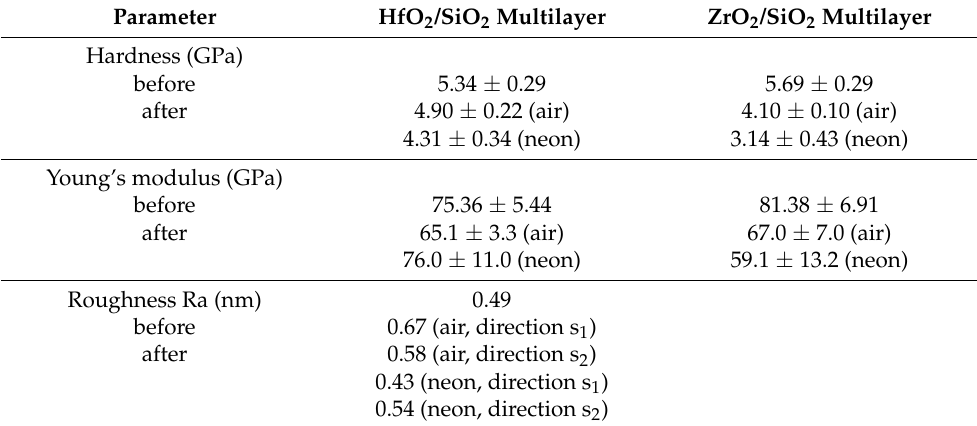
Table 2. Results of mechanical testing of HfO 2 /SiO 2 and ZrO 2 /SiO 2 multilayers before and after UV